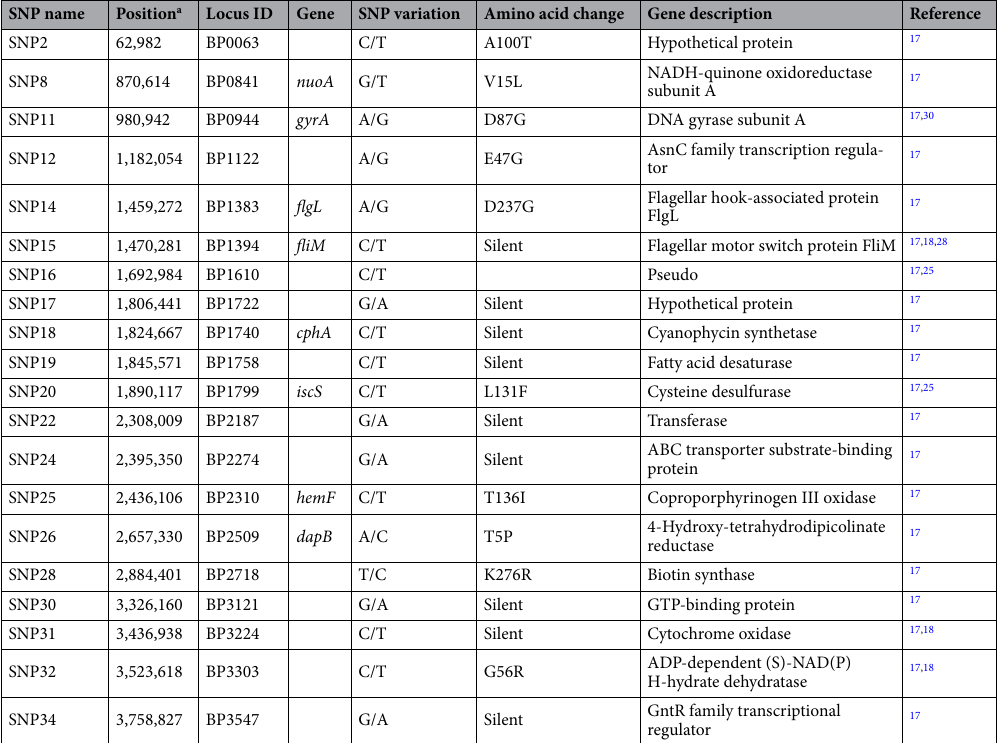
Table 1. SNP markers selected for SNP genotyping using single-base extension assay. a Positions according to the plus strand on Bordetella pertussis Tohama genomic sequence: NC_002929.2.